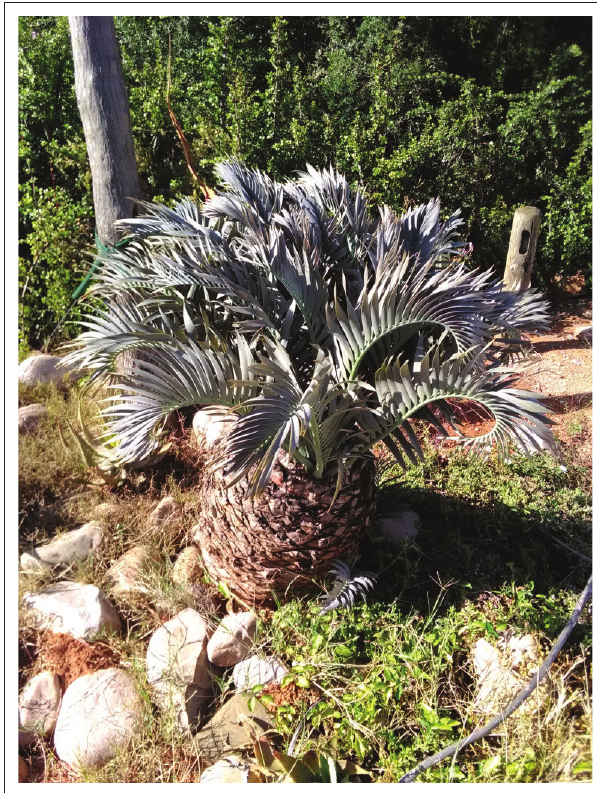
FIGURE 2: Healthy planted individual Encephalartos lehmannii cycad in Addo Elephant National Park garden.